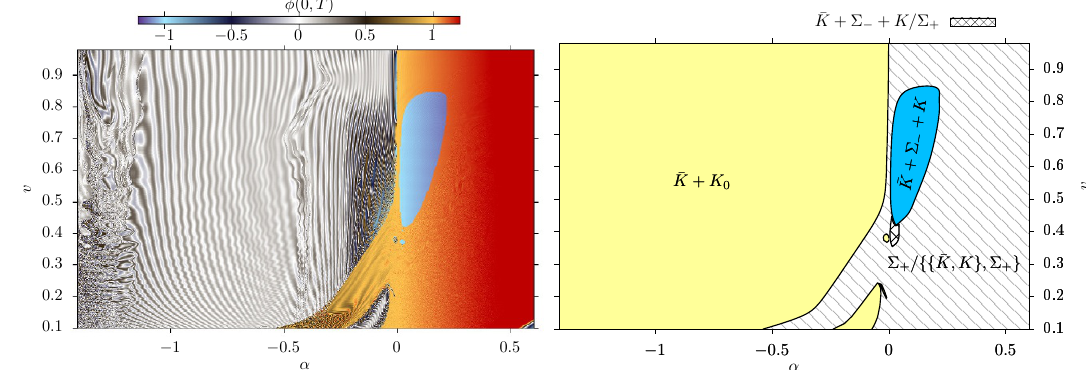
Figure 30 . Di(cid:11)erent scenarios of kink-(antikink-on-impurity) ( (cid:22) K 0 + K ) collisions. The left plot shows the (cid:12)eld value at center at time T after the collision. The right plot shows the products of the collisions. Line (cid:12)lled regions correspond to chaotic